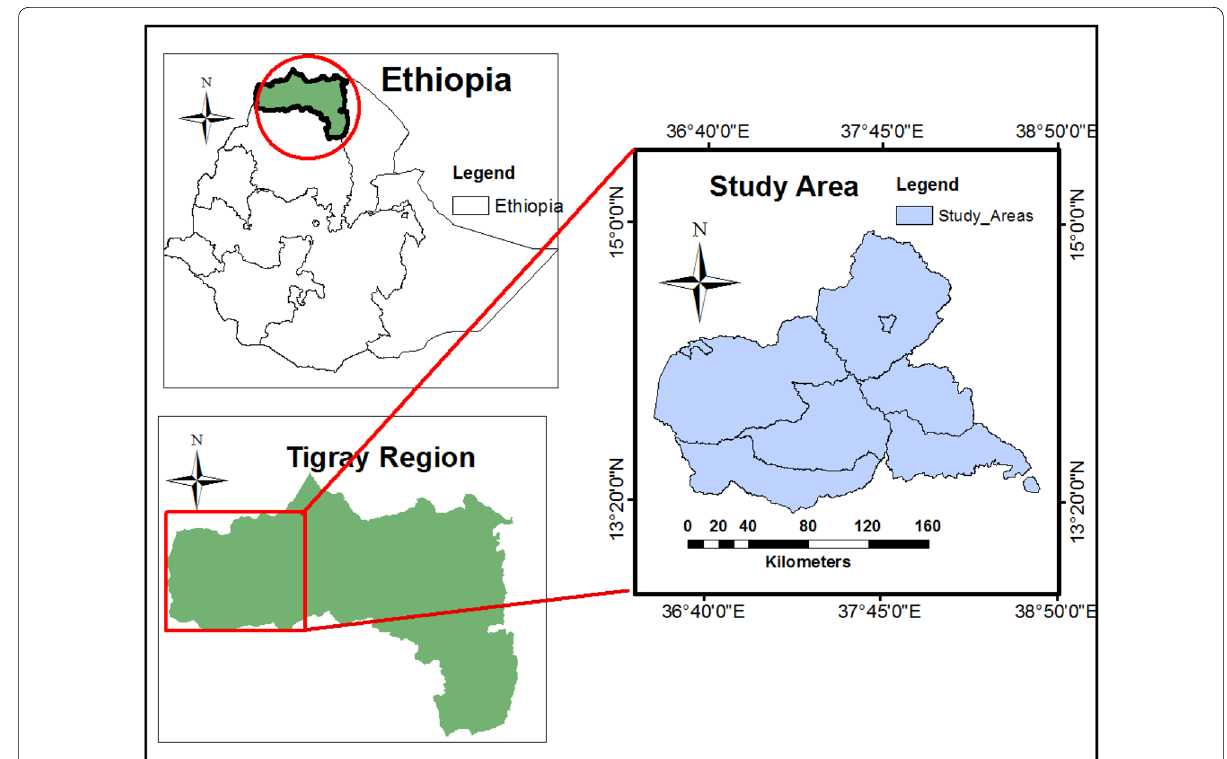
Fig. 1 Location map of the study area